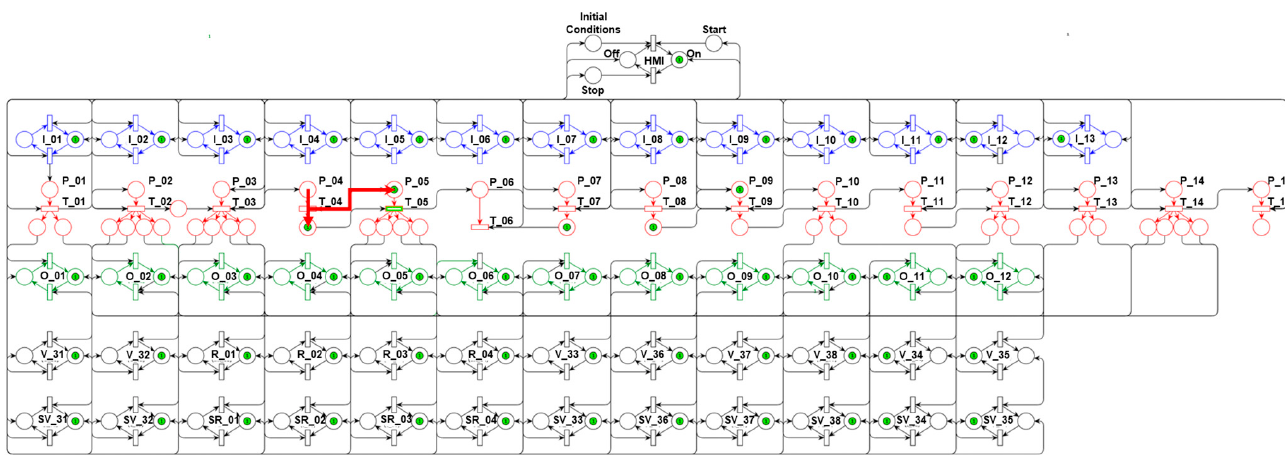
Figure 24. Algorithm’s ninth step—Timer.